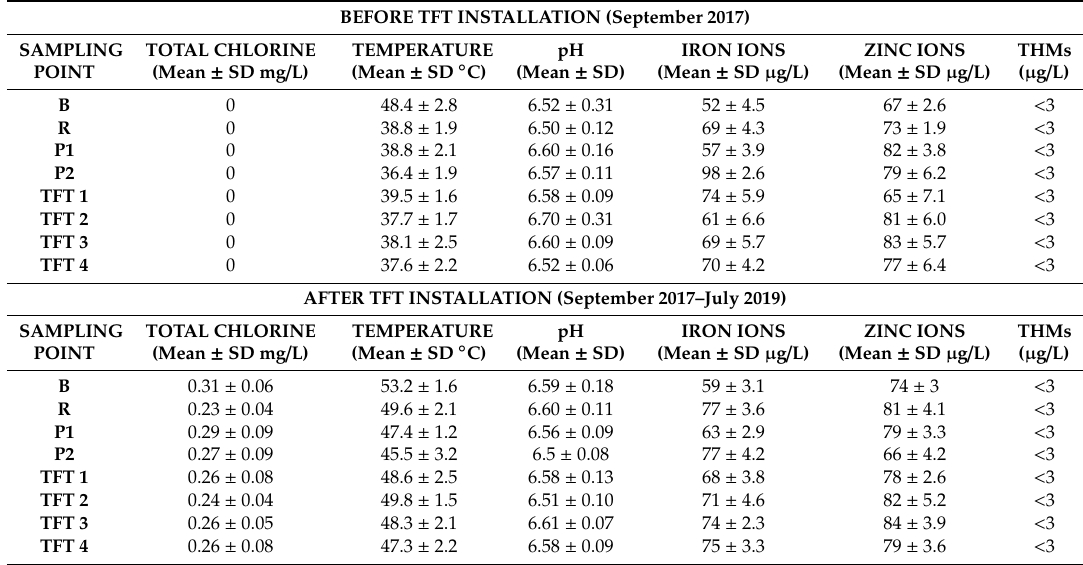
Table 1. Mean values of physical–chemical and chemical parameters assessed at each sampling points before and after TFT installation in Hospital 1. B = boiler; R = recirculation; P1 = point 1; P2 = point 2;